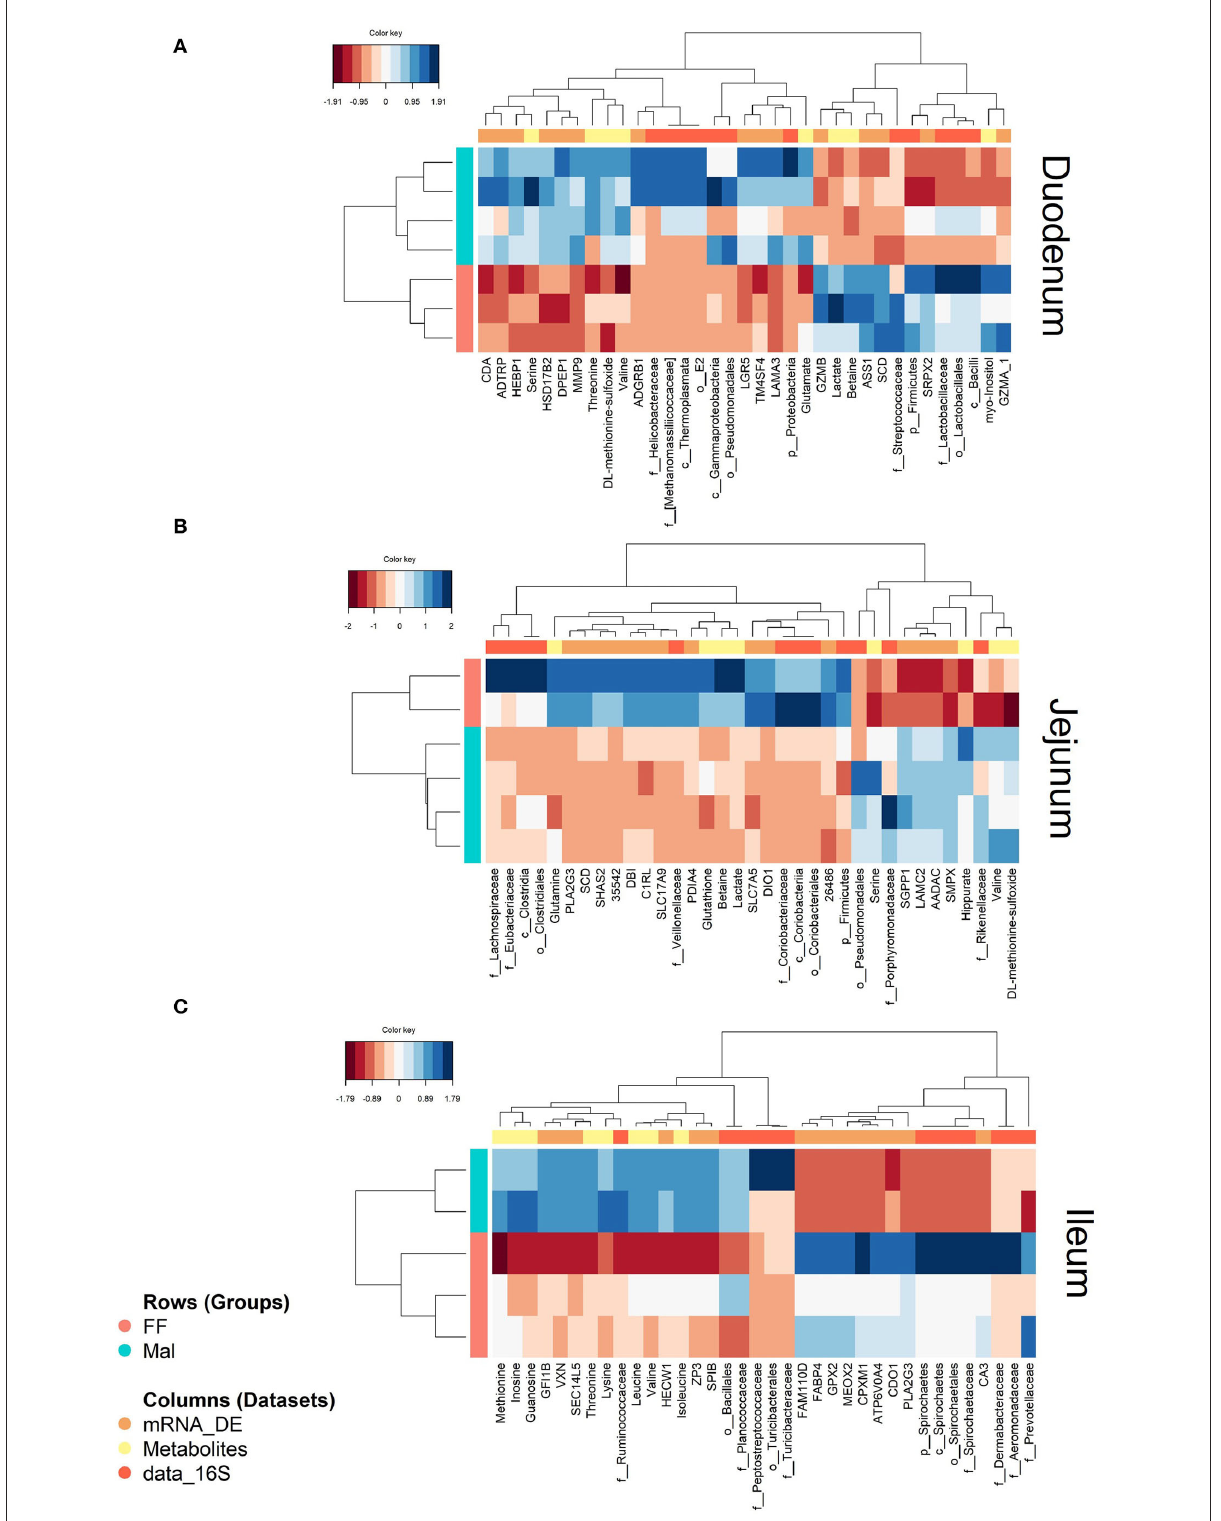
FIGURE7 Heatmaps showing correlations between DE genes (mRNA, orange), microbiota (data_16S, yellow), and liver metabolites (metabolites, dark orange) in full-fed (FF, pink) and malnourished animals (Mal, blue) in the (A) duodenum, (B) jejunum and (C) ileum. The color key represents the level of the variable in the sample from negative (dark red) to positive (dark